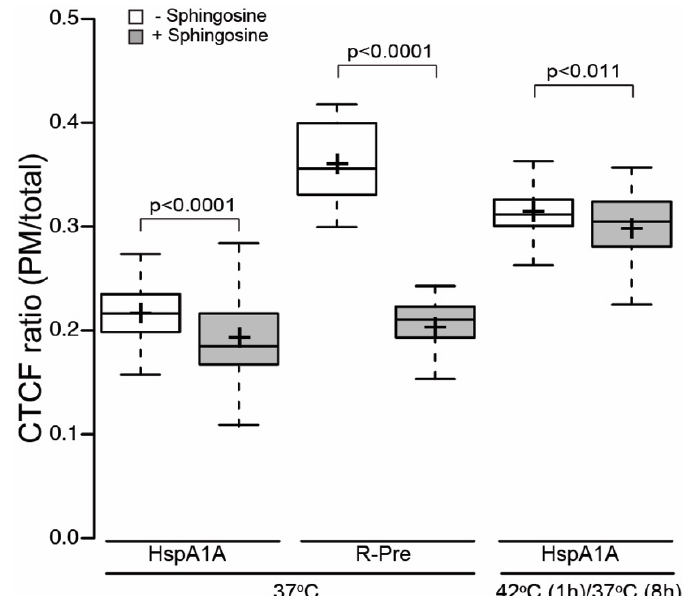
Figure 2. The plasma membrane (PM)-localization of HspA1A is minimally affected by the total membrane charge. Quantification of the corrected total cell fluorescence (CTCF) as a ratio between the total GFP-HspA1A fluorescence of the plasma membrane and the rest of the cell in the presence or absence of sphingosine. The polybasic charge sensor R-Pre-GFP was used as a control. Center lines show the medians; box limits indicate the 25th and 75th percentiles as determined by R software; whiskers extend 1.5 times the interquartile range from the 25th and 75th percentiles; crosses represent sample means. The experiment was repeated three times and the number of cells used to generate each boxplot was (from left to right) n = 48, 32, 28, 26, 41, 39.